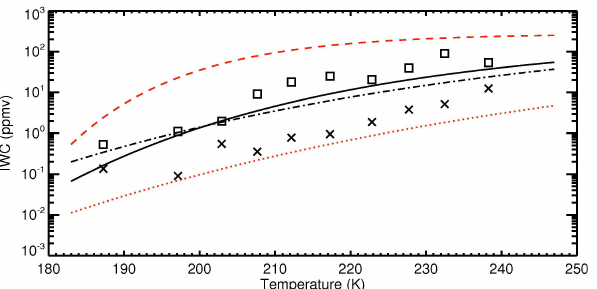
Fig. 8. Peaks of the bimodal PDFs from Fig. 7. “X” is the value of the first (lower IWC) peak, a square is the value of the second. The temperature at which they are plotted is the weighted mean temper- ature for each temperature bin. The black line represents the median fit line for the merged climatology, not including tropical deep con- vective data. The black dashed line is the median fit from Schiller et al. (2008) and includes convective data. The red dashed/dotted lines depict the maximum/minimum envelope of the most frequent ( > 5%) IWC as seen in Fig. 6 of Schiller et al. (2008). Fig. 9. (a) Top: PDF of IWC; (b) Bottom-left: PDF of crystal num-